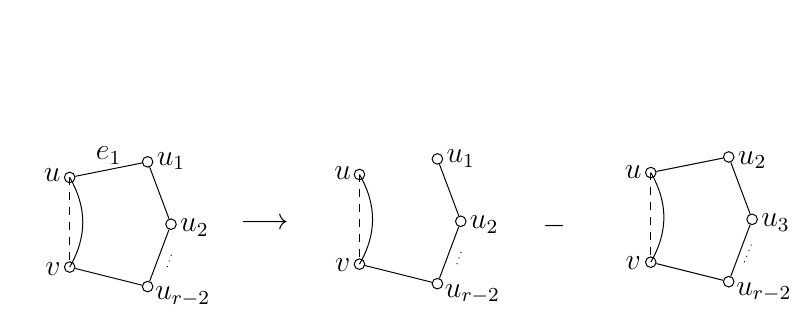
Figure 4: An application of edge deletion-contraction on B 1